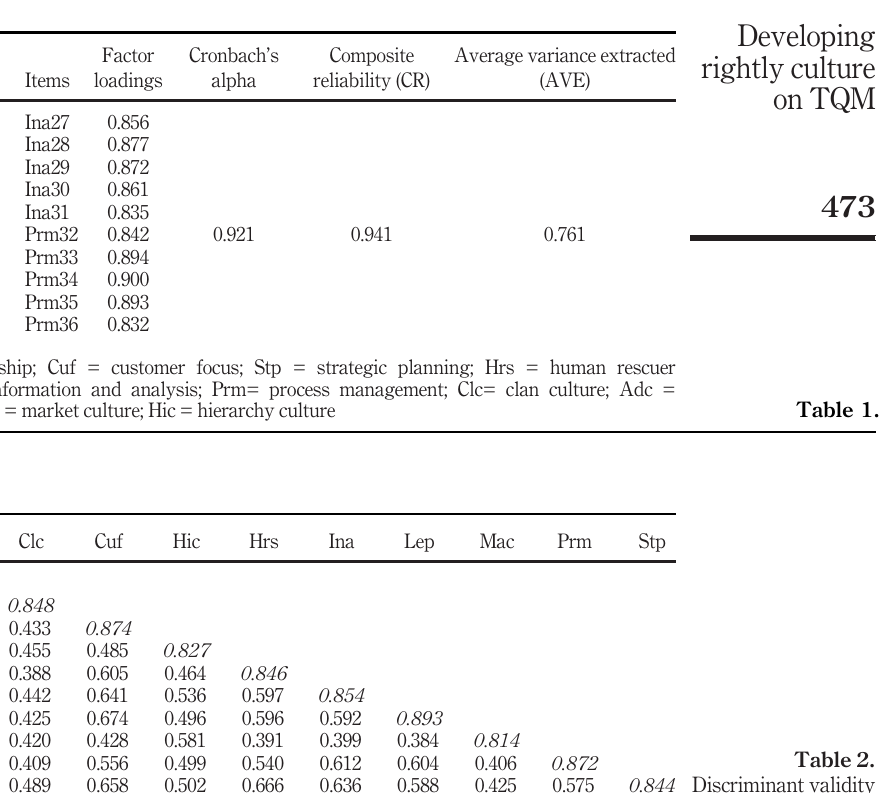
Table 2. Discriminant